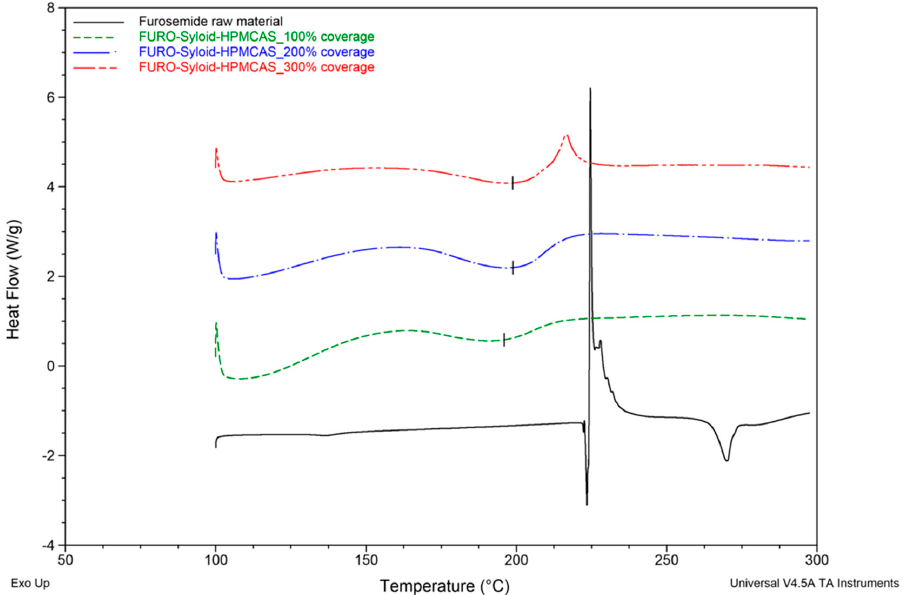
Figure 9. DSC thermograms of the raw Furosemide material and FURO-Syloid-HPMCAS at various drug loads. Scanning rate: 10 °C/min. Scanning range: 100 – 300 °C.